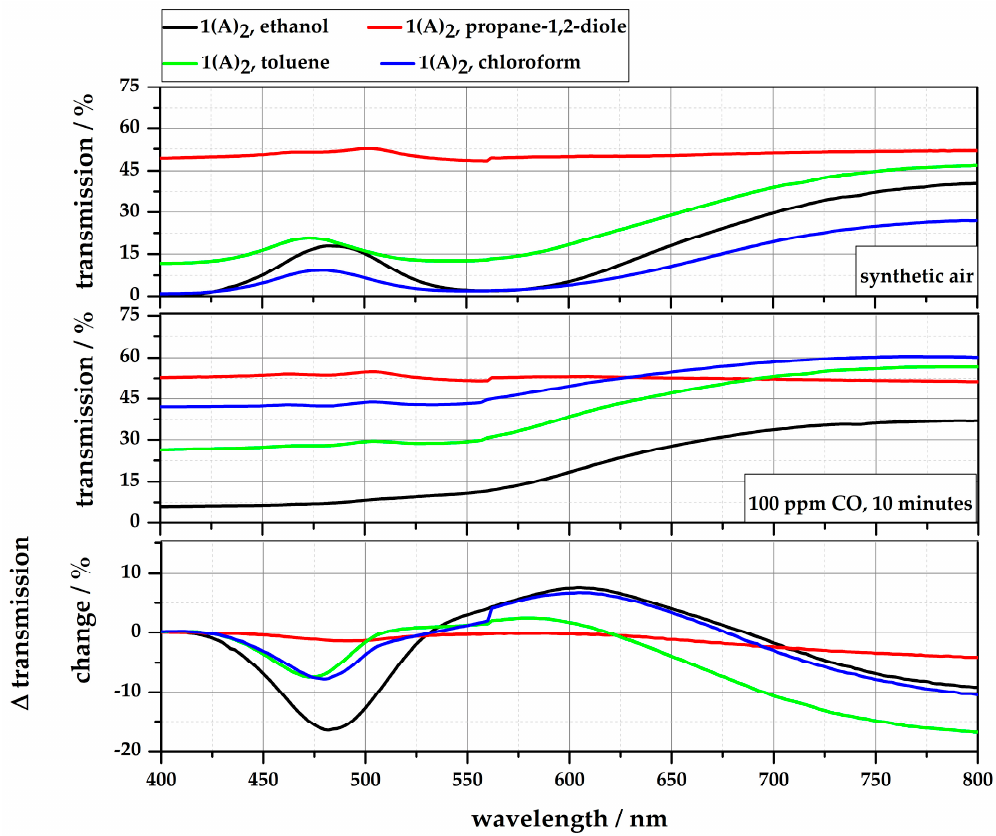
Figure 7. Difference of the transmission change ( Δ T/%) of 1 ∙ (A) 2 dissolved in ethanol, propane-1,2-diole, toluene, and chloroform, before and after exposure to 100 ppm for 10 min.